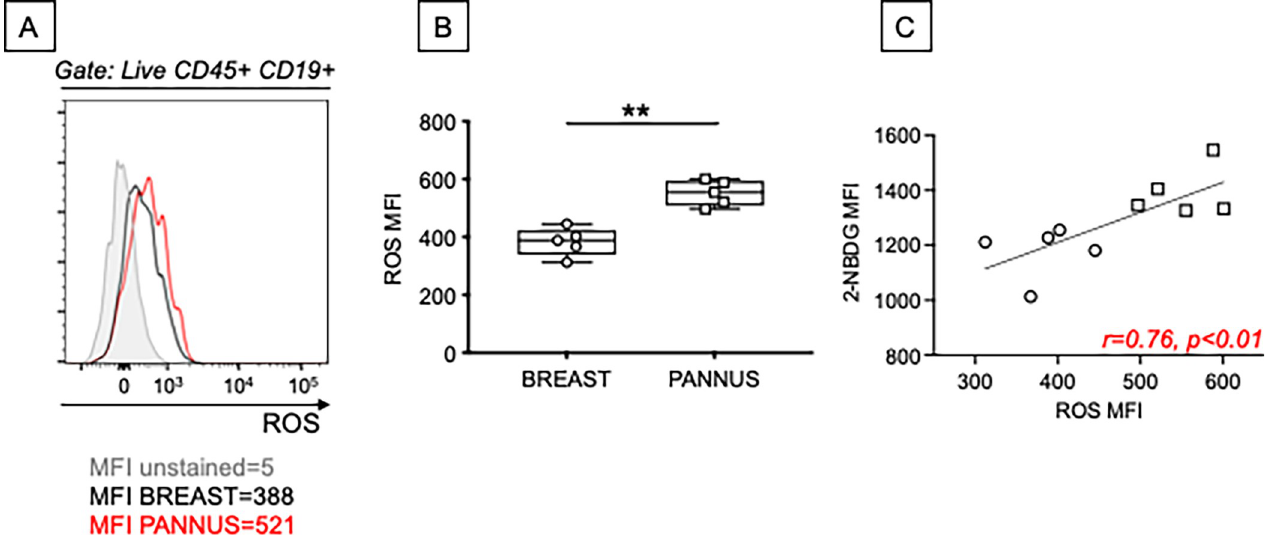
Fig 9. B cells sorted from the pannus, as compared to those sorted from the breast, express higher levels of ROS and 2-NBDG. B cells were isolated from pannus and breast SVFs from the same individuals in Figs 7–9. After sorting, B cells were left unstimulated and evaluated by flow cytometry for ROS production. A. Results show MFI of ROS staining in B cells sorted from pannus and breast SVFs from one representative experiment, as compared to the unstained control. B. MFI ± SE of ROS staining from all samples. Mean comparisons between groups were performed by Student’s t test (two-tailed). *** p < 0.001. C. Correlation 2-NBDG and ROS. Each symbol represents an individual, n = 5 breast donors and n = 5 pannus